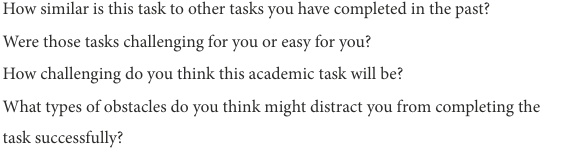
TABLE 1 Prompts completed by the experimental condition during time estimation assignment part 1. Prompts